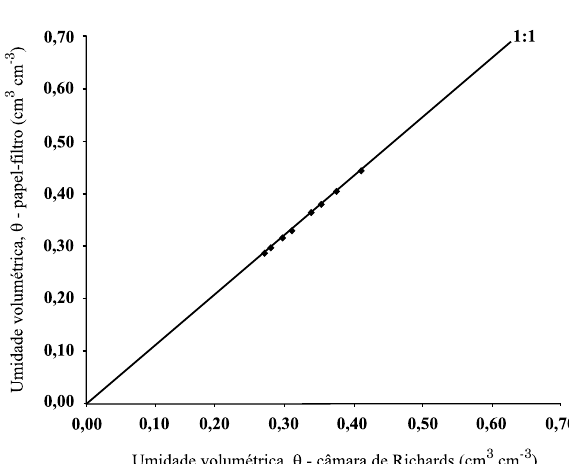
Figura 2. Valores da umidade volumétrica estimada pela câmara de Richards e pelo método do papel-